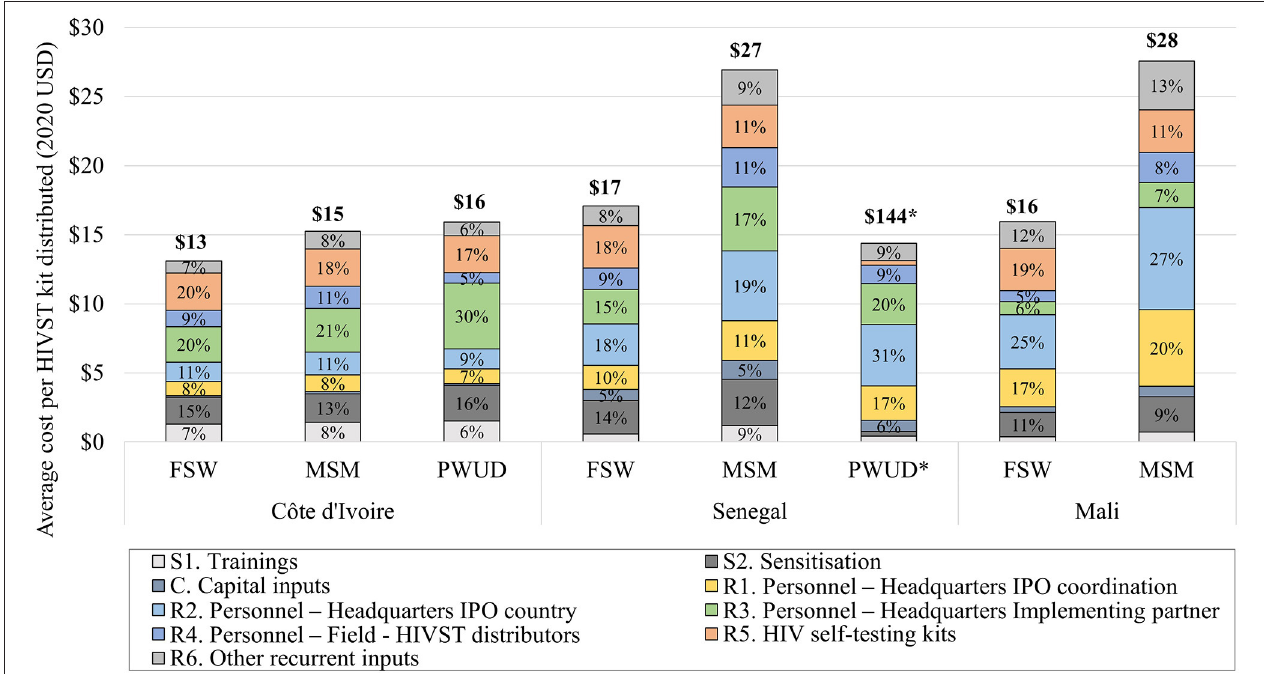
FIGURE 2 | Average intervention costs by inputs for each key group—Côte d’Ivoire, Senegal, and Mali. *For PWUD in Senegal, costs are presented on this figure divided by 10 for scale purpose.